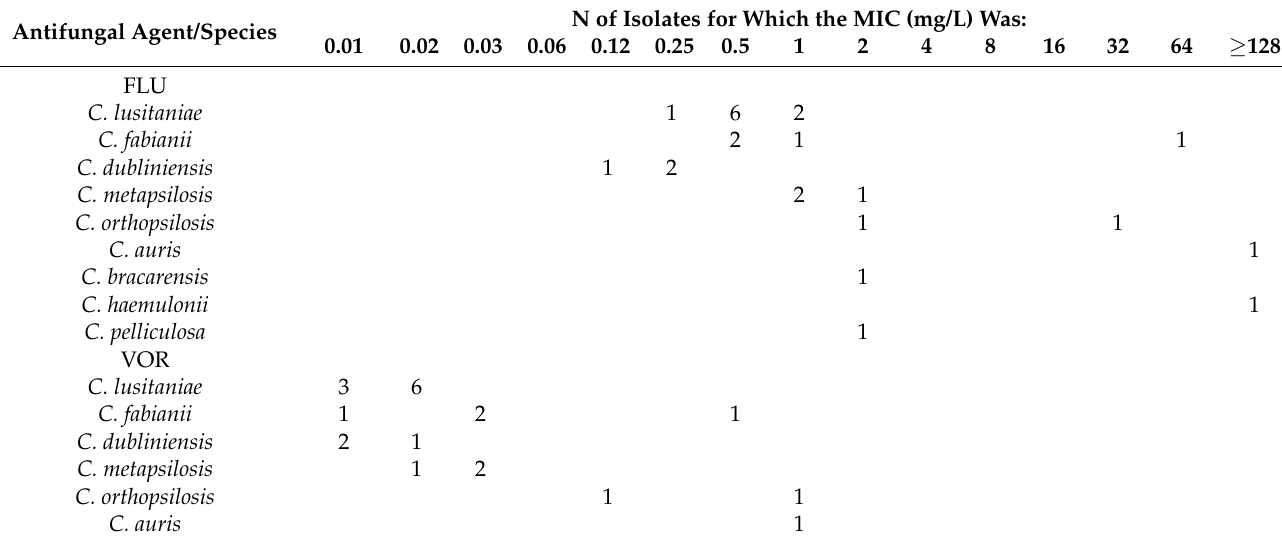
Table 4. Distributions of MIC values to antifungal agents of uncommon Candida species which clinical breakpoints are unavailable in CLSI